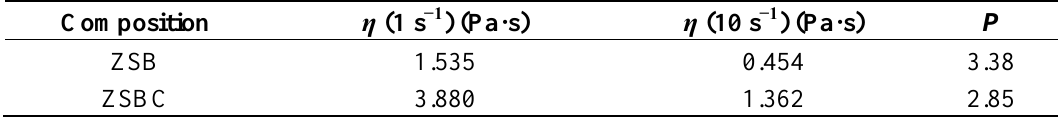
Table 2. Shear-thinning properties of ZSB and ZSBC